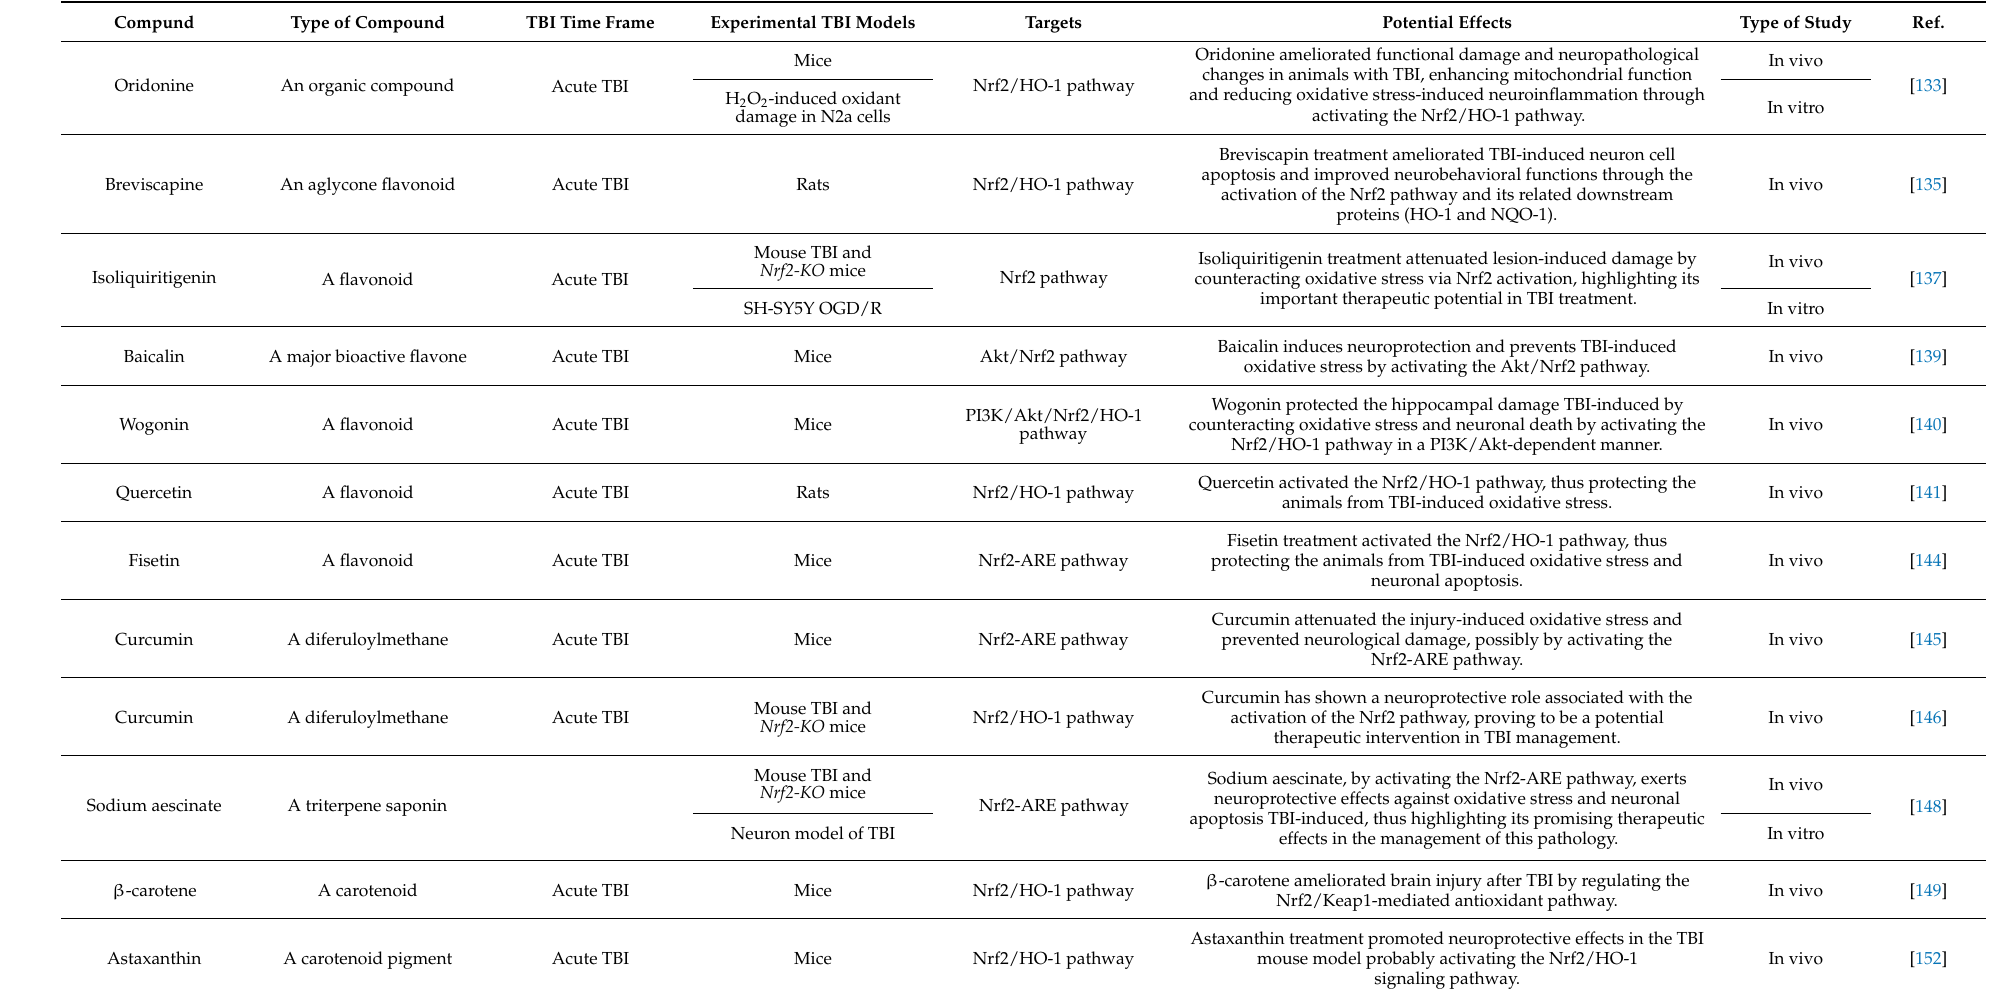
Table 2. Potential natural compound Nrf2 activators for controlling TBI symptoms and improving functional